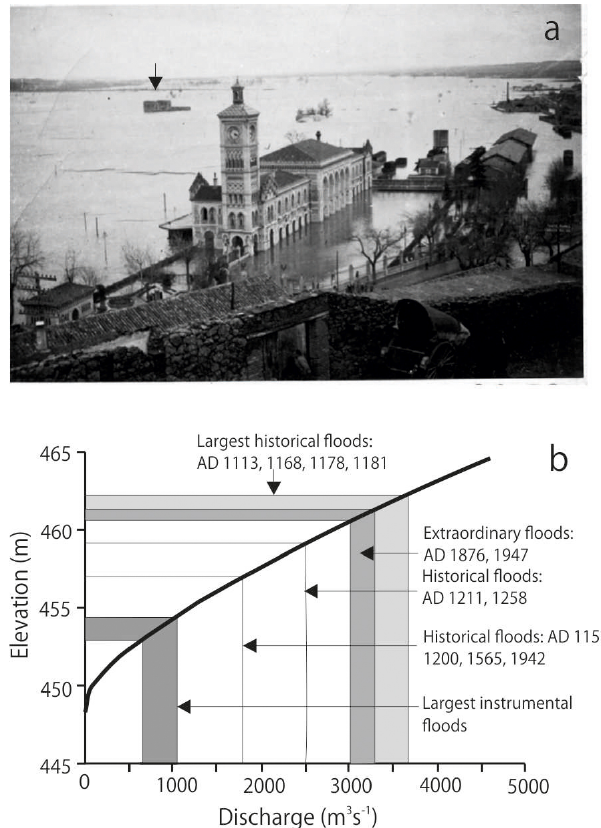
Figure 4. (a) Upstream view of the River Tagus into the Huerta del Rey (King’s Garden) during flooding on 6 March 1947 at Toledo (Spain). The peak discharge was reached at 10:00 and the picture was taken at 15:20 (by courtesy of Mariano García Bargueño). The water level at peak discharge was ca. 1.5m above the railway sta- tion ground level (main building at the centre of the photo). In the background the arrow points out the Galiana Palace, on the left bank of the Tagus River, just over 1km from the old part of Toledo (the Galina Palace was built at the site of an earlier summer villa and Arab garden of Al-Mamun, king of the Taifa of Toledo in AD 1043– 1075) (Benito et al., 2003a). (b) Rating curve of a cross section next to the upper picture obtained from step-back water calculations (HEC-RAS model) with the elevation of relevant historical flood ev- idence (flood marks and description of inundated sites). The largest historical floods occurred during the Medieval Climatic Anomaly and are followed by the 1876 and 1947 floods (Fernandez de Vil- lalta et al.,